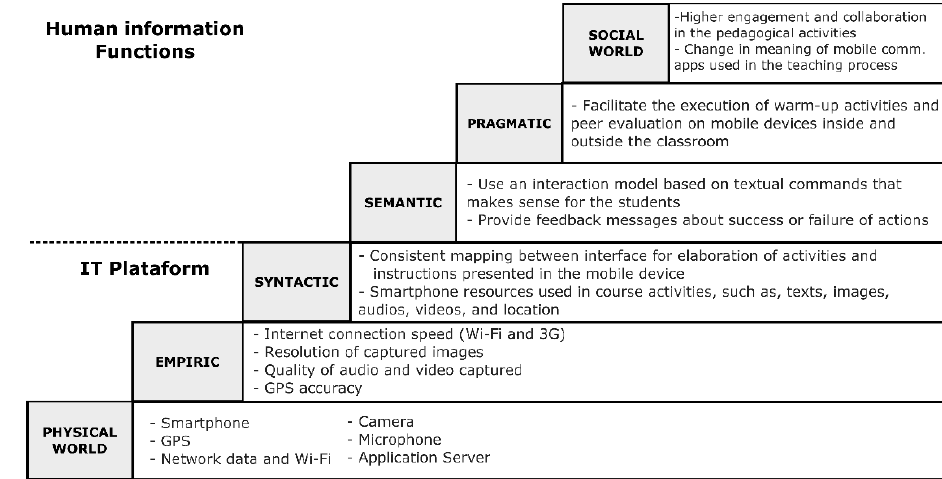
Fig 3. Semiotic Ladder with system requirements